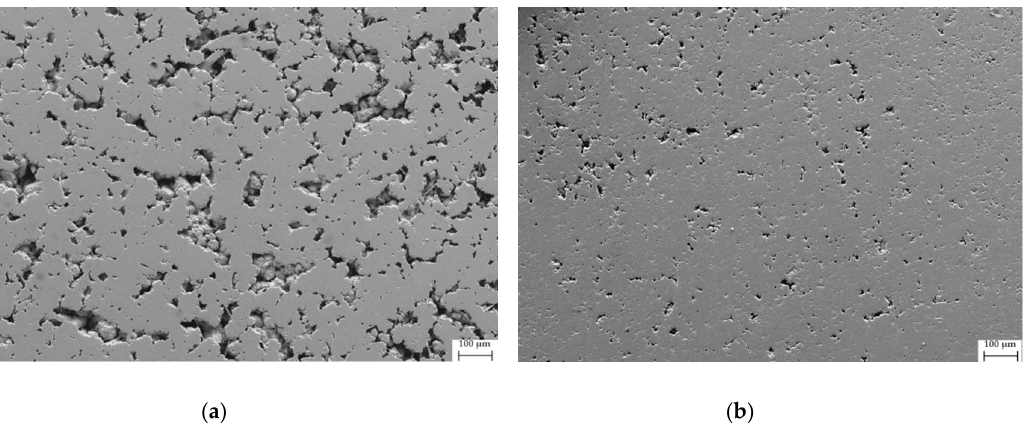
Figure 7. SEM microphotograph taken by secondary electrons on the polished surface of sample ( a ) Fe50_bulk and ( b ) Fe50_SPS.